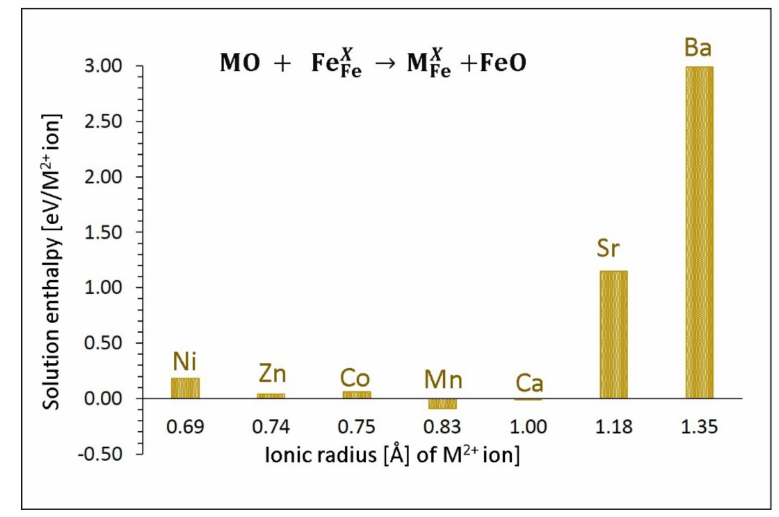
Figure 5. Enthalpy of solution of MO (M = Ni, Zn, Co, Mn, Ca, Sr, and Ba) with respect to the ionic radius of M 2 + in FeTiO 3